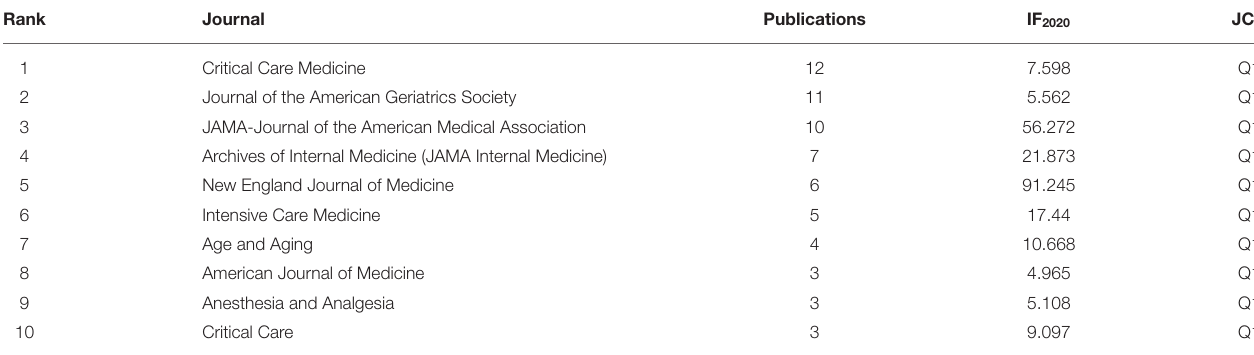
TABLE 3 | Journals with top-10 number of papers included in the top-100 articles.